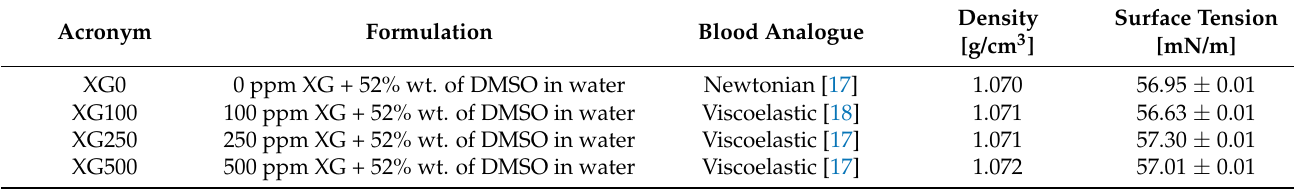
Table 1. Composition and properties of the working solutions.